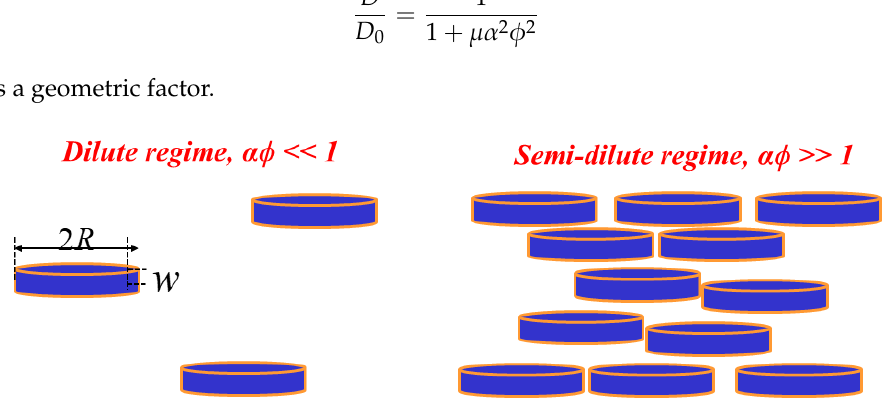
Figure 8. Schematic illustration of the dilute and the semi-dilute regimes of the oriented disk-shaped platelets.